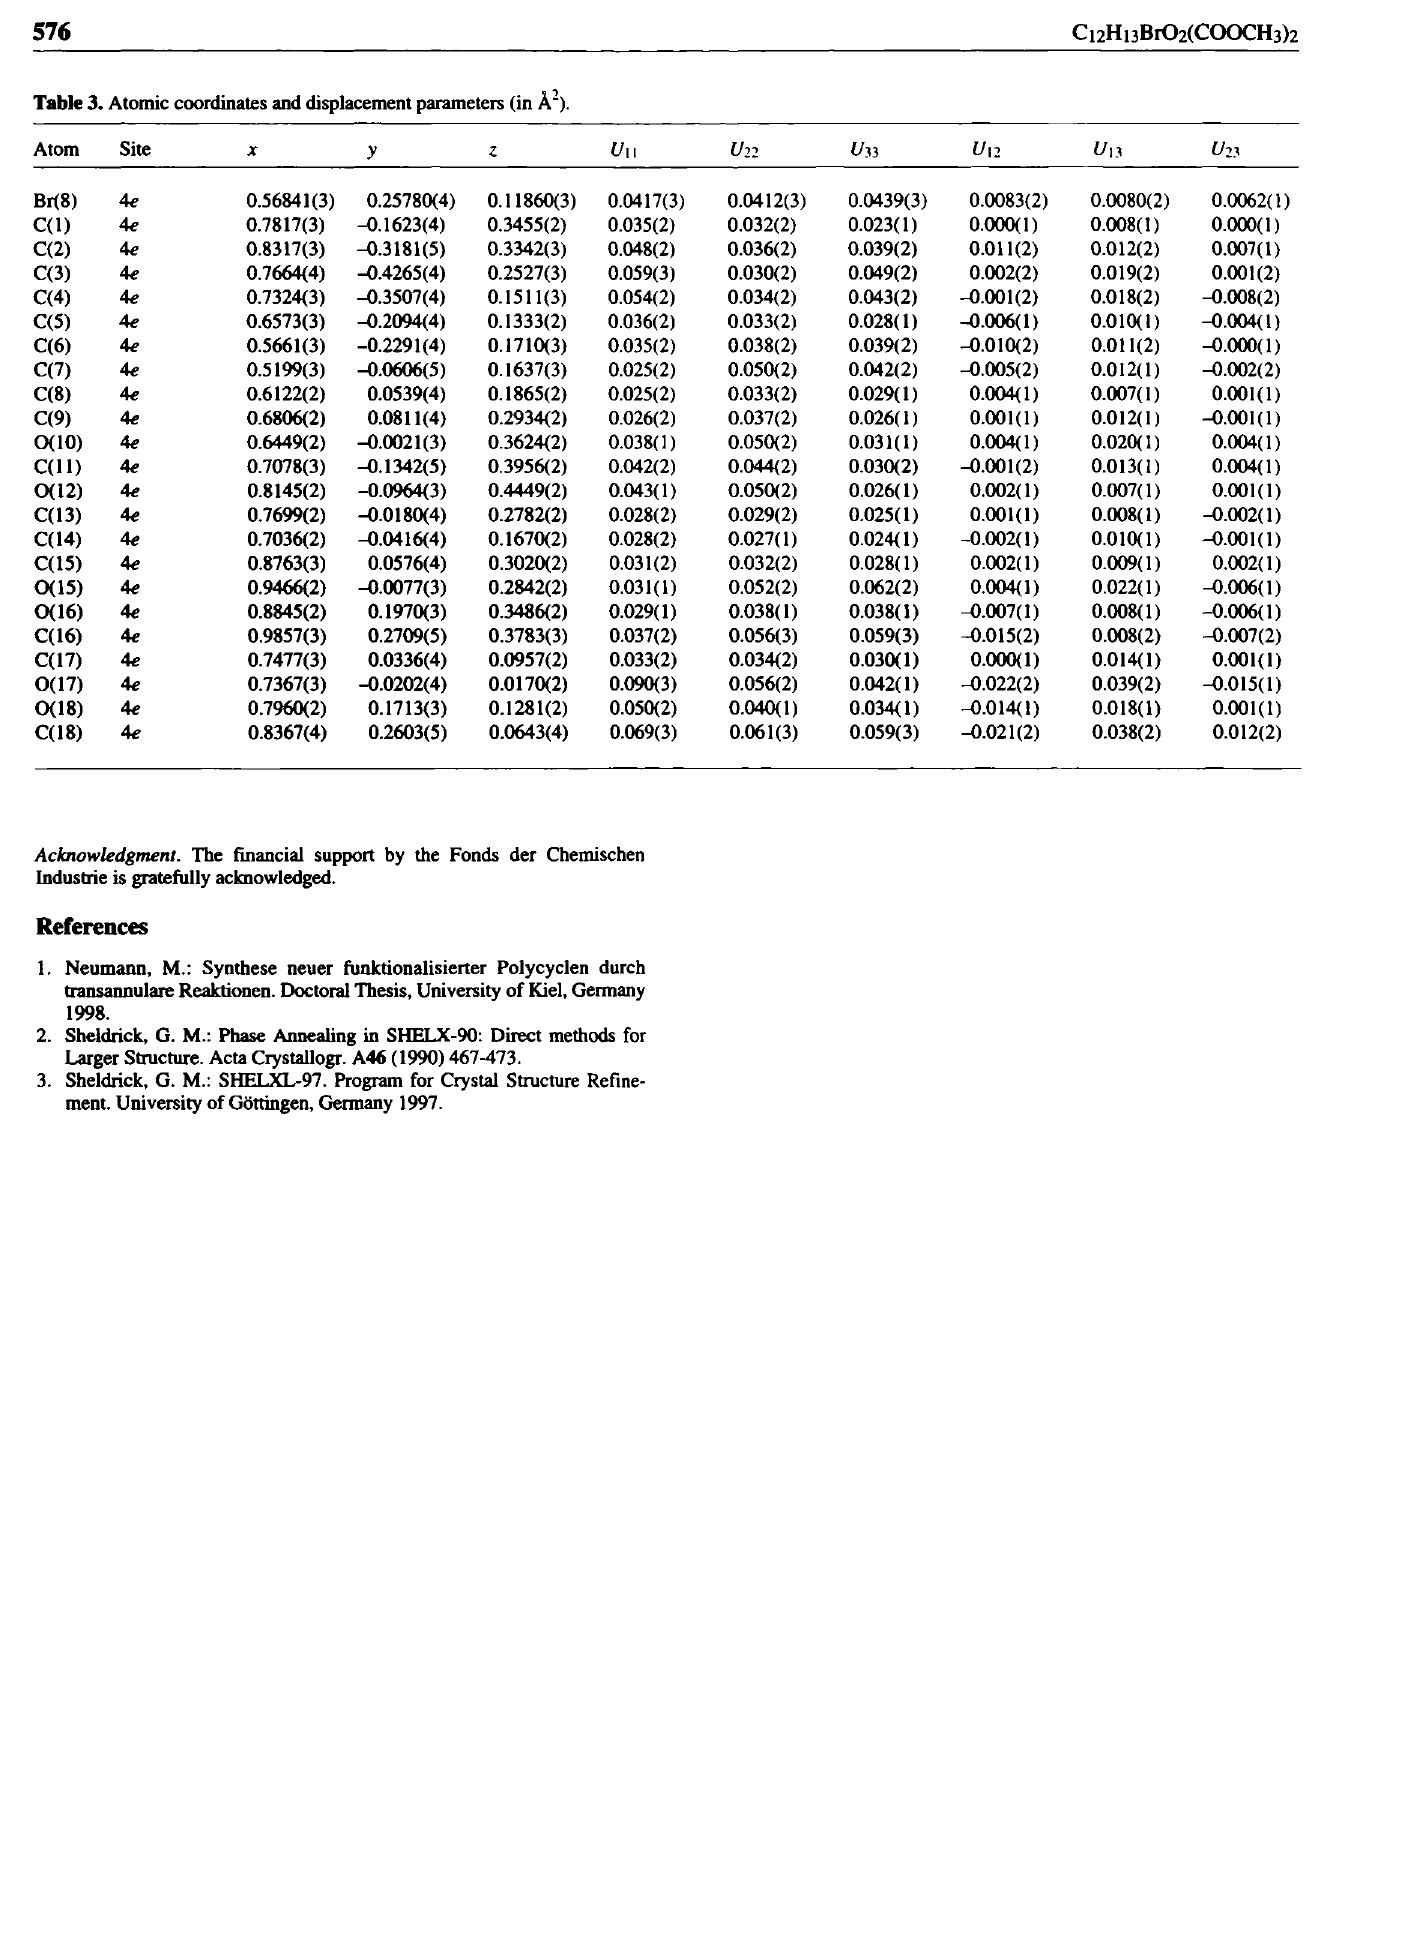
Table 3. Atomic coordinates and displacement parameters (in À 2